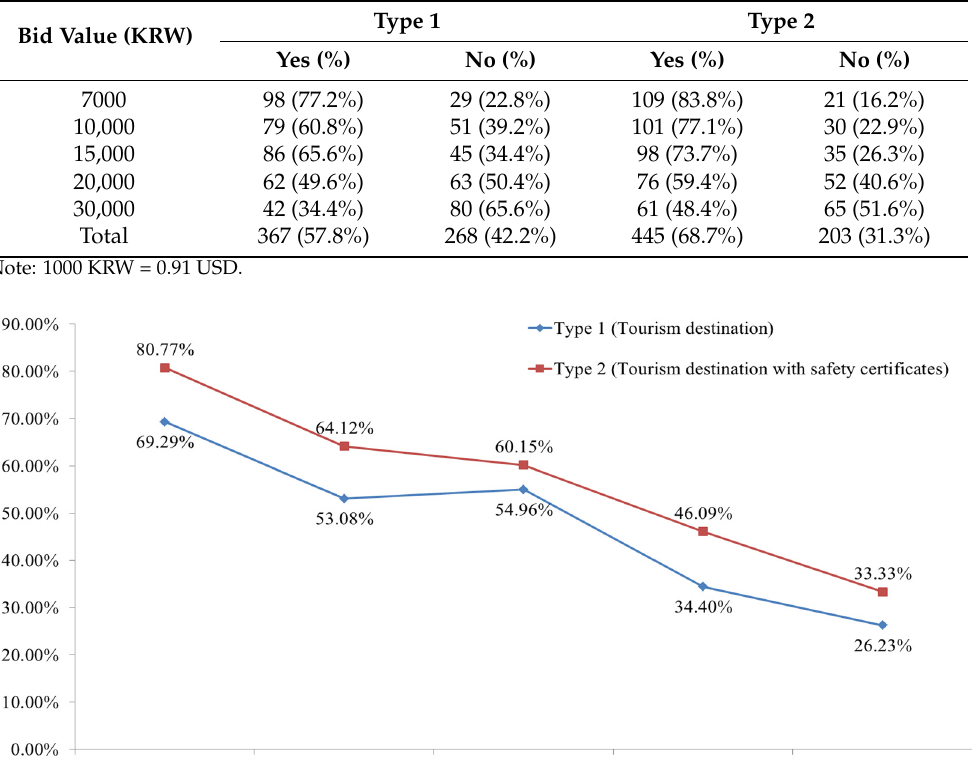
Table 1. Response ratio per bid value.